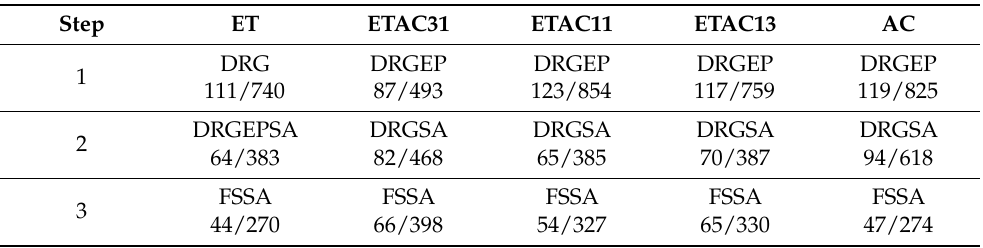
Table 2. Methods used in the mechanism reduction process and number of species/reactions after each step (the detailed mechanism includes 581 species and 3037 reactions).